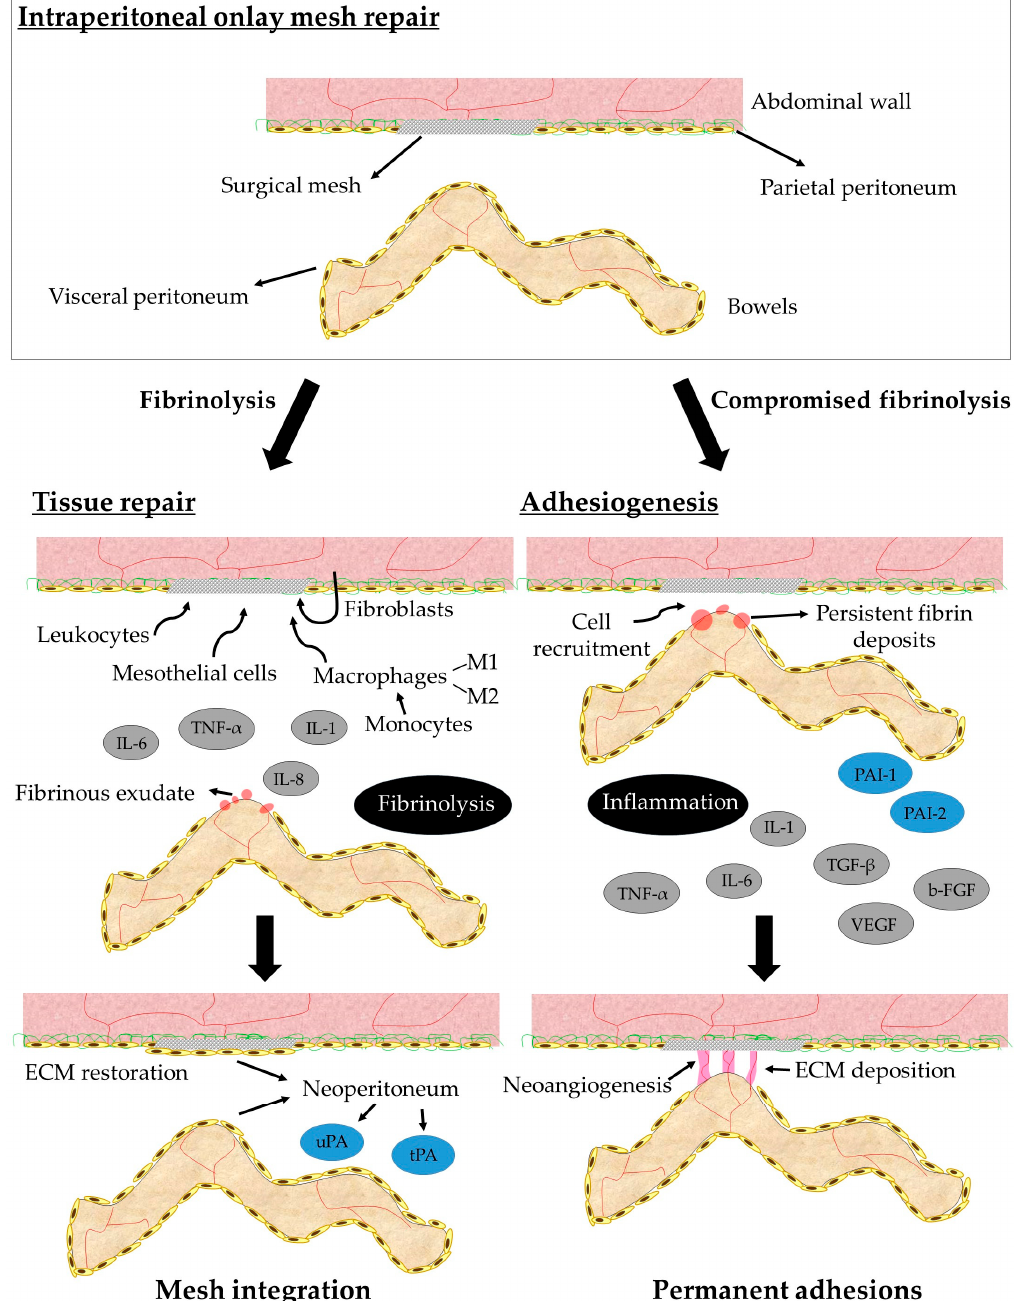
Figure 1. Diagram showing the two possible pathways after peritoneal injury during intraperitoneal onlay mesh repair. The presence of a mesh into the abdominal cavity produces an inflammatory response and the appearance of a fibrinous exudate in the damaged areas. Under normal circumstances (left panel), the fibrinolytic system degrades fibrin and a neoperitoneum is formed, leading to tissue repair and mesh integration. If fibrinolysis is inhibited or delayed (right panel), fibrin deposits persist and permanent tissue connections (adhesions) are established between opposing surfaces. ECM, extracellular matrix.